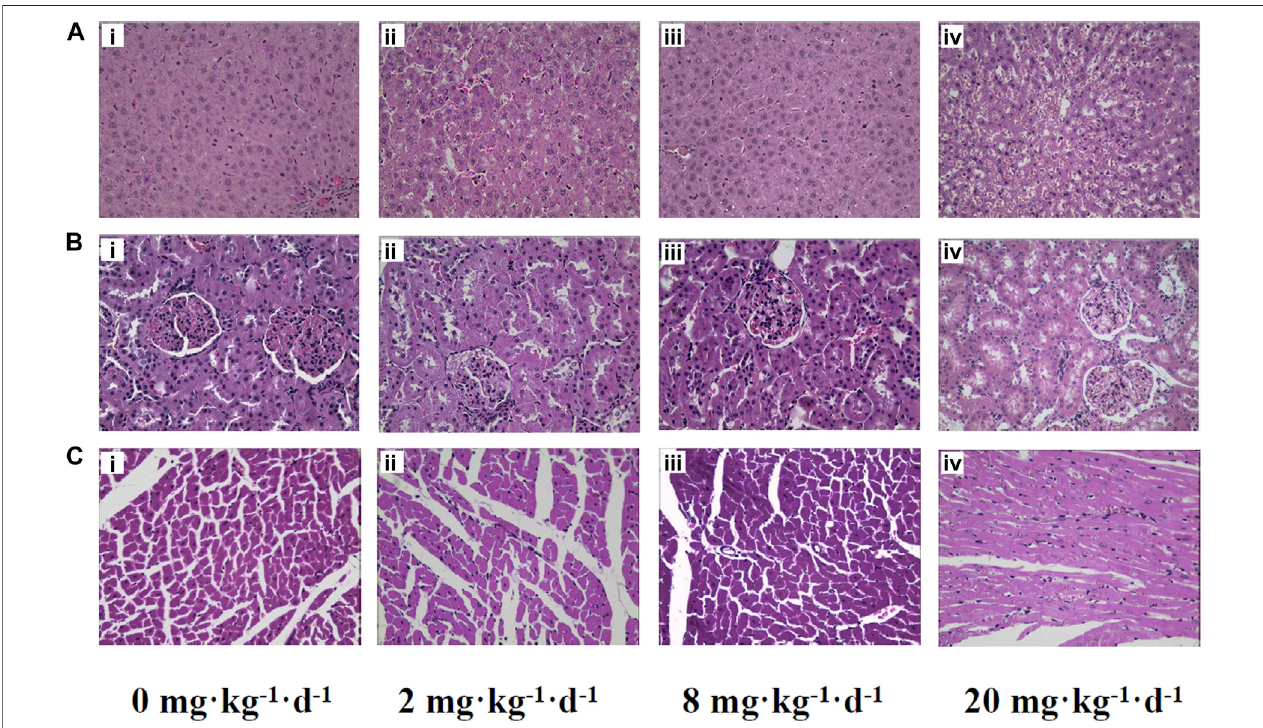
FIGURE4| Representativehistopathologyslicesofratsliver (A) ,kidney (B) ,heart (C) followingtheintragastricadministrationofATOfor28 days (i) 0 mg kg − 1 d − 1